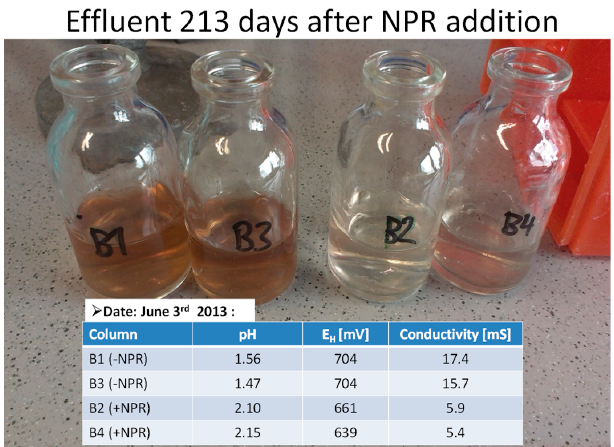
Figure 4. Effluents from coal columns after 213 days since onset of the leach experiment. Carbonaceous phosphate mining wastes (CPMW = NPR) were added to columns B2 and B4, but not to B1 and B3. Since we know that biofilm formation is stimulated by NPR we changed the designations used in all previous publications, as we suspect the carbonaceous nature is more important than the phosphate